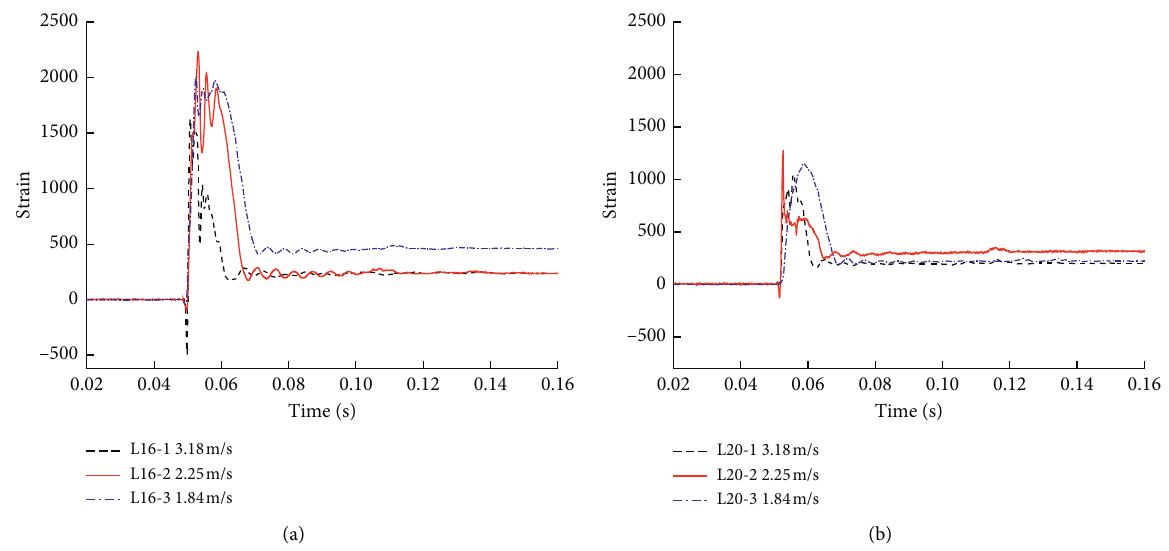
Figure 5: Time-history curves of the strain: (a) Group A; (b) Group